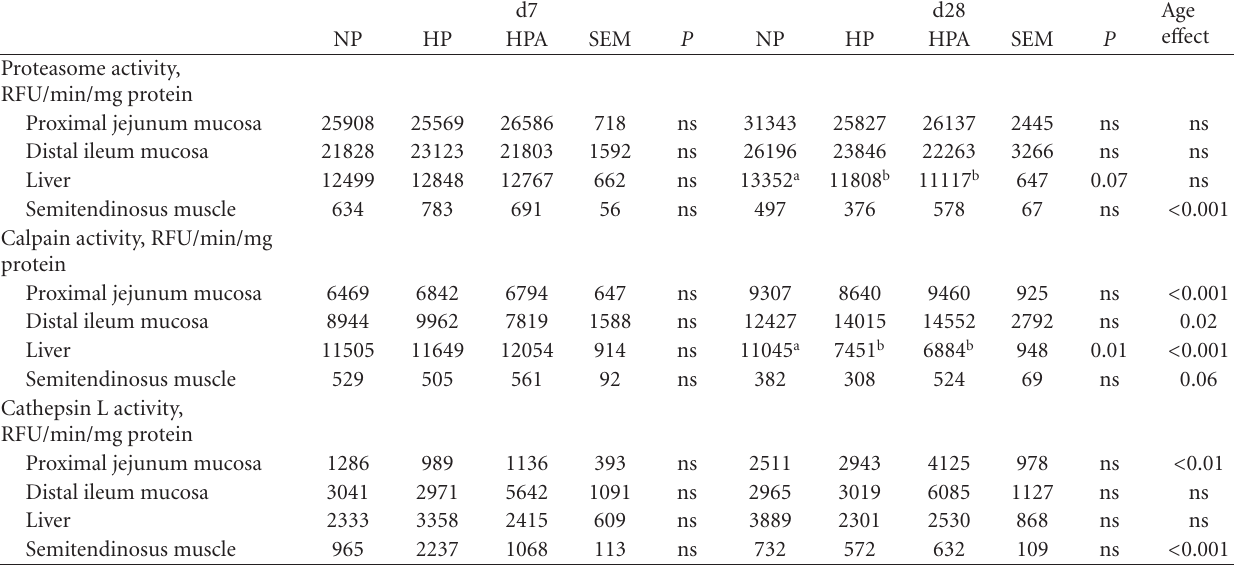
Values are least square means and pooled SEM calculated in pigs slaughtered at d7 and d28, n = 6/group. P (e ff ect of formula) and age e ff ects are presented. Di ff erences were considered significant when P < 0 . 05 but trends are presented when 0.1 < P < 0 . 05. Means with a di ff erent superscript letter di ff er at P < 0 . 05. Table 6: Proteasome, calpain, and cathepsin L activities (RFU/min/mg protein) measured in various tissues of piglets fed NP, HP, and HPA diets at d7 and